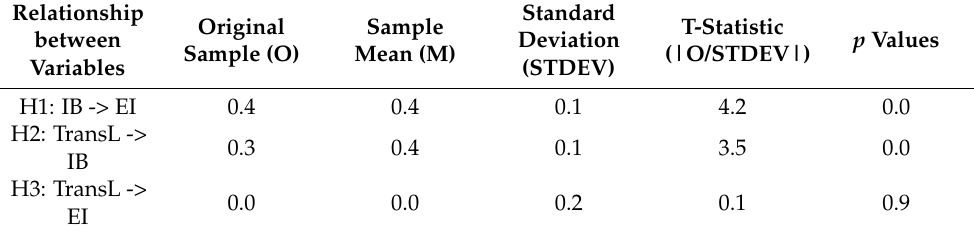
Table 3. Path coefficients and bootstrapping results.